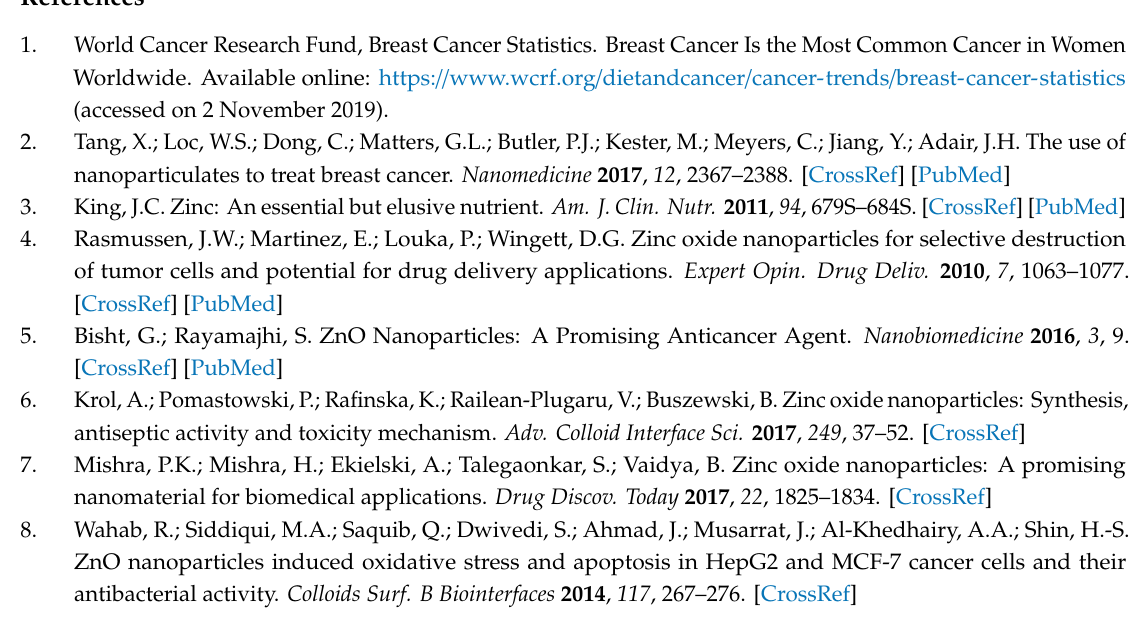
Figure S1: A schematic representation of the design of the study; Figure S2: Contribution of di ff erent classes of metabolites detected in extracts obtained from the rats’ blood serum after the application of protocol proposed by O. Fiehn for the metabolome screening by the GC–MS assay; Figure S3 A–E: Examples of metabolites identified by MS Dial software in serum based on the calculated value of RI and similarity scores. The Fiehn metabolomics library was used for the identification process; Figure S4: The principal component analysis used for the general data overview. Score plots show some discrimination between groups: rats with the zinc nanoparticles supplementation (green dots—n) and the other groups: rats on a standard diet (non-supplemented group) - (blue dots—s) and with the microzinc supplementation (red dots—m); Figure S5: Metabolites which were found to be di ff erentially accumulated across three experimental groups. Blue lines indicate the pairwise di ff erences (FDR < 0.05); Figure S6: the principal component analysis performed on two groups—rats on the standard diet (green dots—s) and rats with Zn NPs supplementation (red dots—n) (A). Features were additionally auto-scaled. Loading plot (B); Figure S7: Metabolites of significantly altered abundance between the non-supplemented group (green color—s) and the one supplemented with zinc nanoparticles (red color—n); Table S1: Metabolites of altered abundance across three groups based on the one-way ANOVA test with the results of the post hoc test indicating di ff erences between particular groups; Table S2: Metabolites of altered abundance across two groups based on the t-test / Welch’s test / Wilcoxon rank-sum test, in regard to normality and homoscedasticity of data,